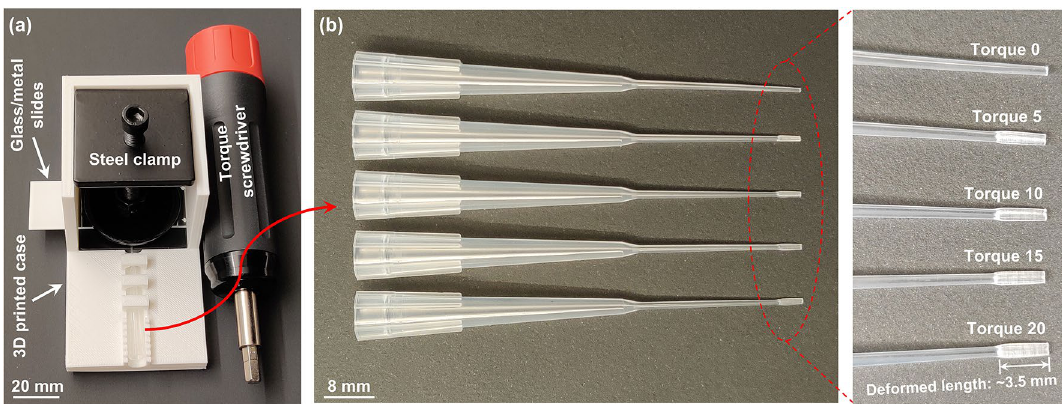
Figure 2. Standardized pipette tip modification to prepare head-flattened tips. ( a ) The simple tip deformation tool is easily assembled with a 3D printed case, two glass/metal slides, a steel clamp and a torque screwdriver. When using, a pipette tip is inserted between or under the two glass/metal slides. The glass/metal slides cannot rotate freely once assembled with the 3D-printed case and will transfer the torque force to pressure to deform the head part of the commercial pipette tip. ( b ) By setting the torque on the torque screwdriver from zero to twenty, modified pipette tips (deformed length: ~ 3.5 mm) with various degrees of deformation of the head parts are